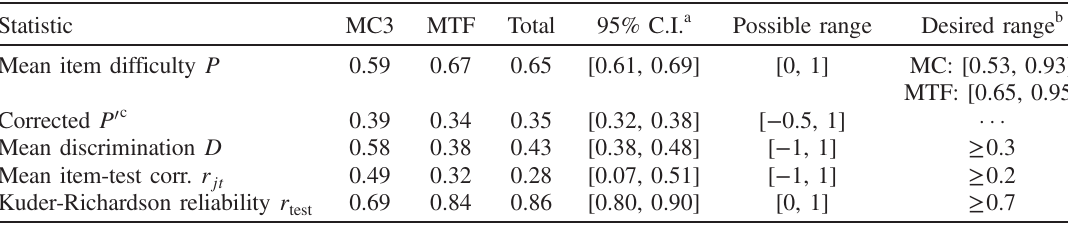
TABLE IV. Pretest statistics for each item group and for the total score along with the 95% confidence interval of the combined score as well as possible and desired ranges of item